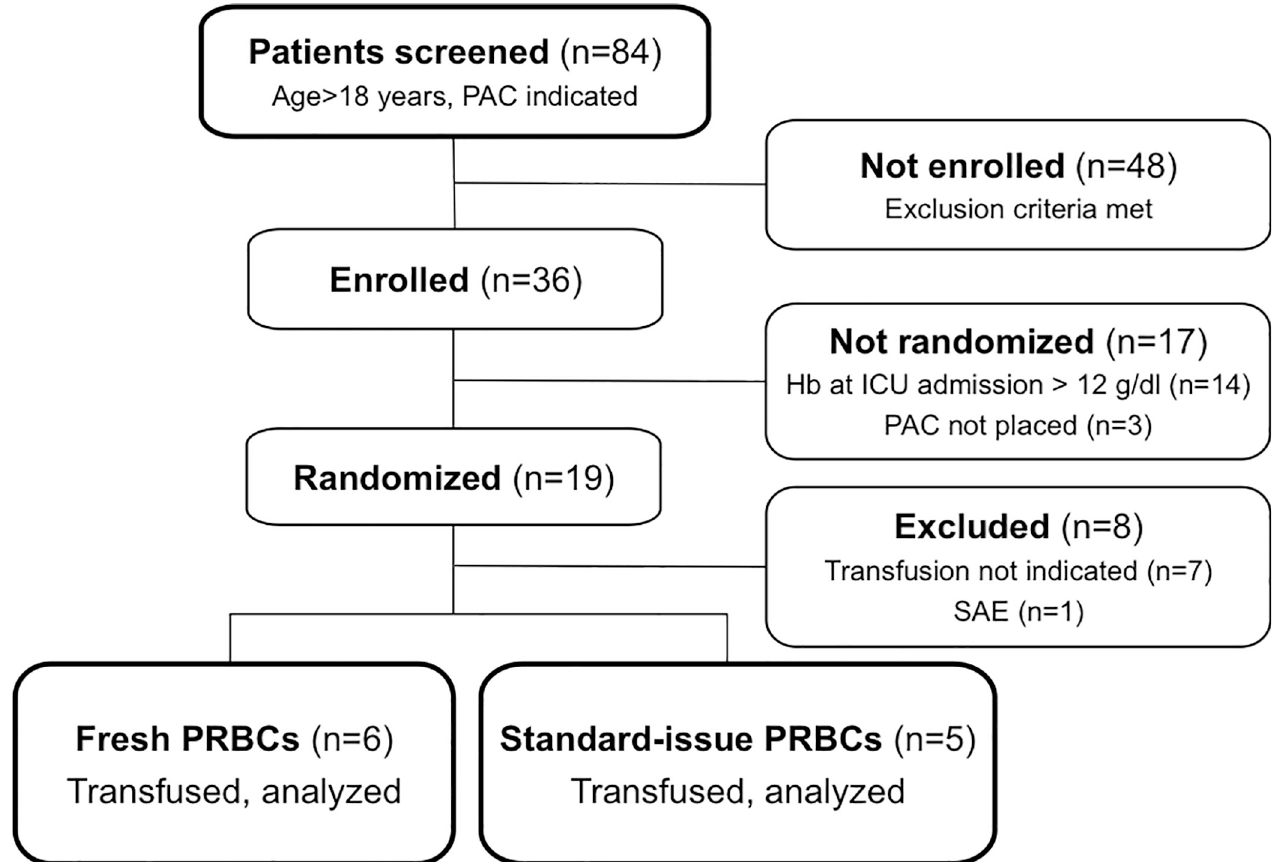
Fig 1. Study participation flow diagram. Abbreviations: PAC, pulmonary artery catheter; Hb, hemoglobin; ICU, intensive care unit; SAE, serious adverse event; PRBCs, packed red blood cells.